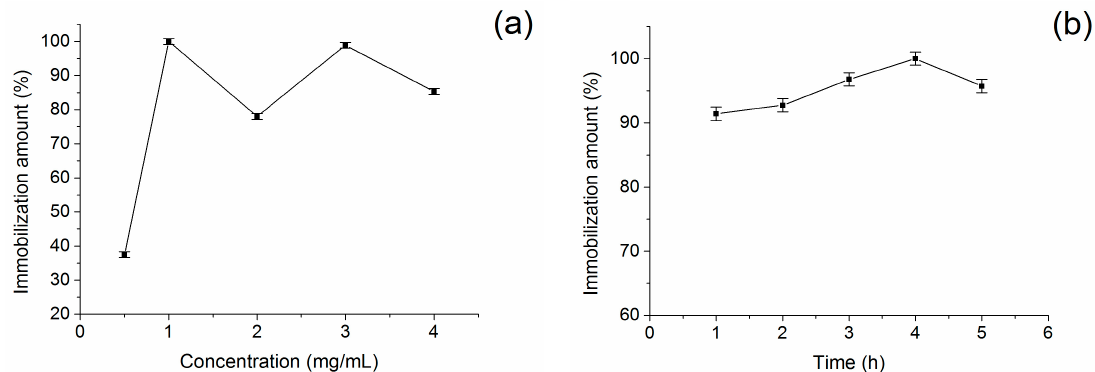
Figure 6. ( a ) Effect of BSA concentration on immobilization when the immobilization time was 4.0 h; and ( b ) effect of immobilization time on immobilization when the BSA concentration was 1.0 mg/mL.